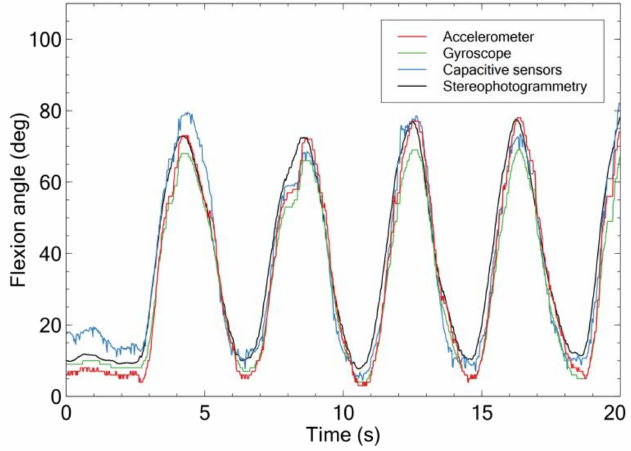
Figure 5. Example of flexion signals simultaneously detected by the calibrated capacitive sensors, accelerometer, gyroscope, and stereophotogrammetry.